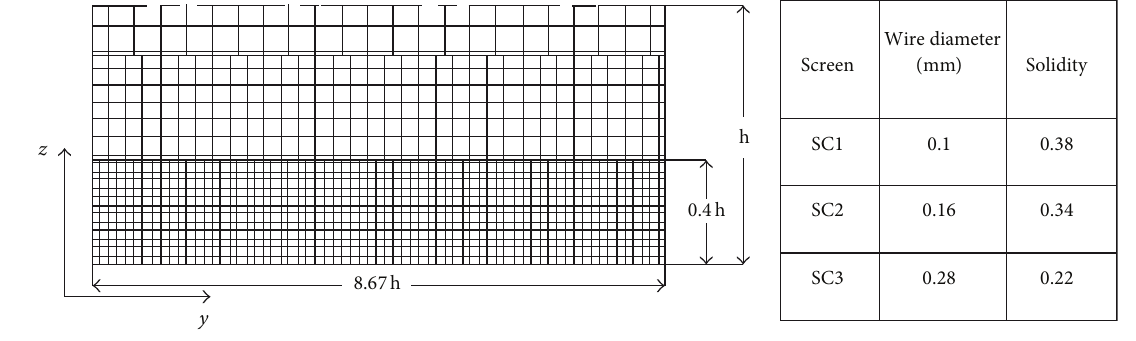
Figure 1: Details of shear flow generator consisting of strips of screens.